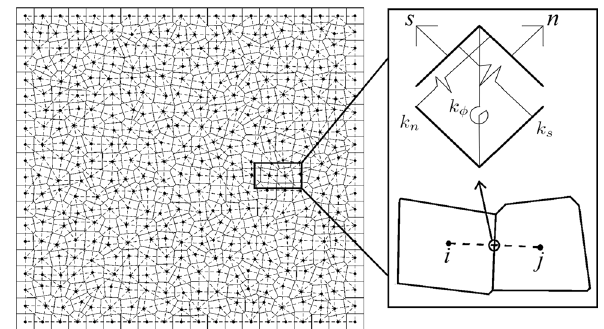
Figure 3. The generated Voronoi cells and the defined spring